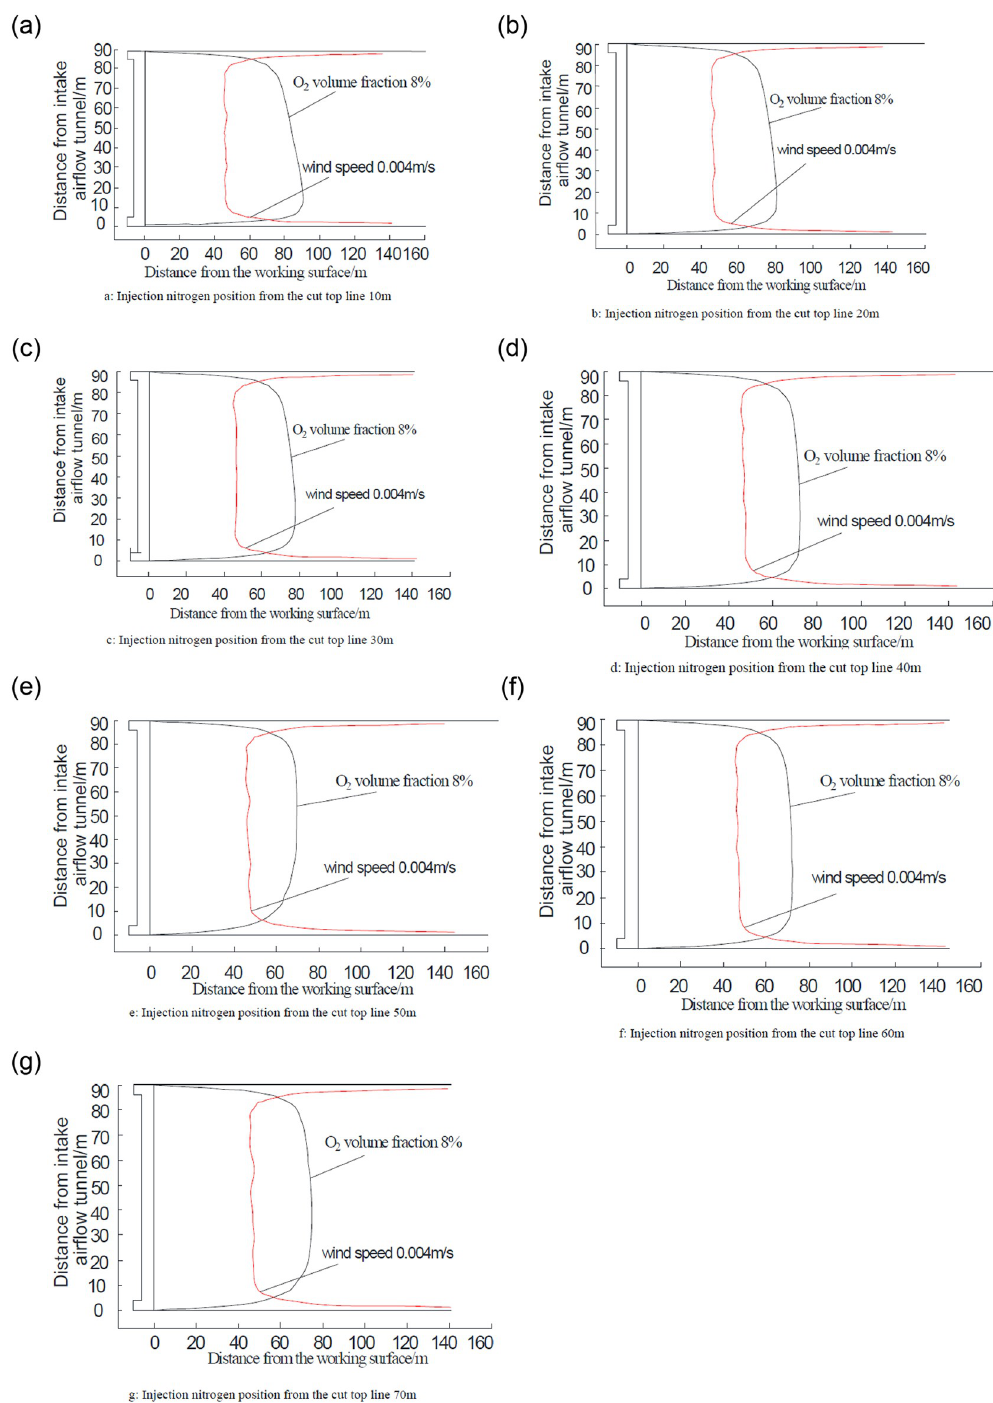
Fig 4. Goaf oxidized zone distribution under different injection nitrogen